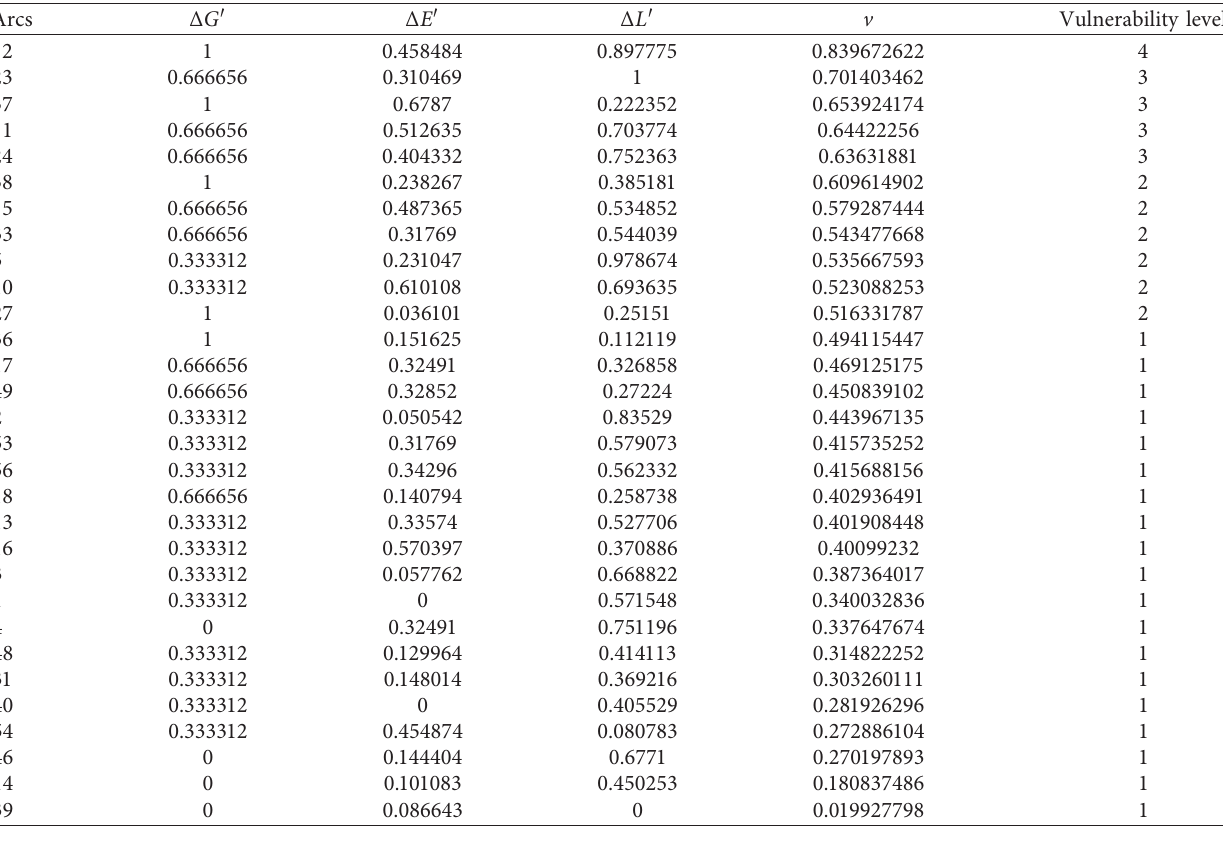
Table 10: Comprehensive identification results of road network vulnerability based on connectivity, network efficiency, and traffic performance.